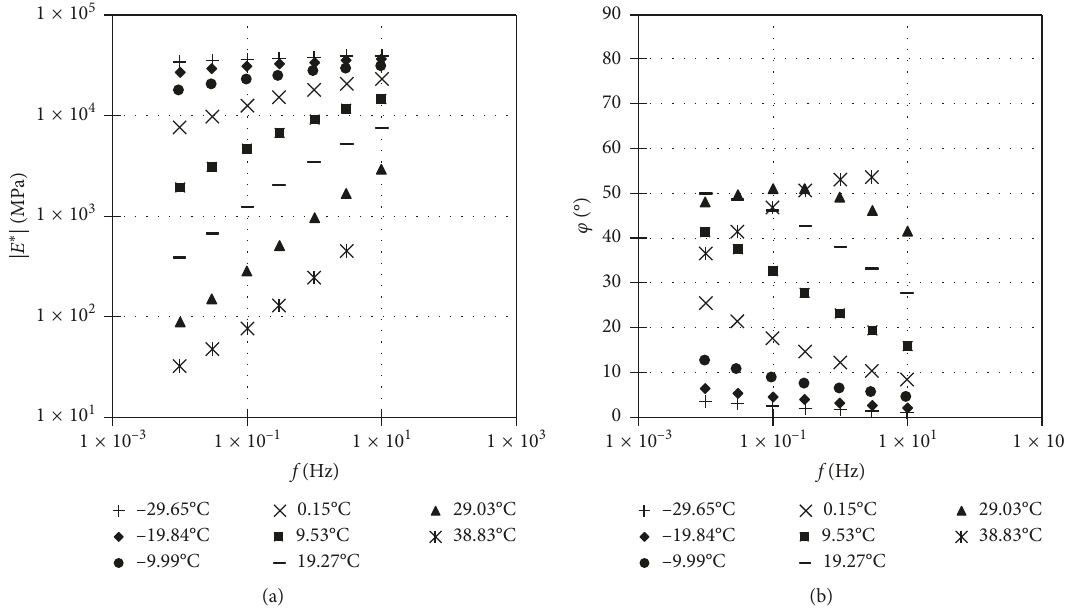
Figure 3: Experimental data of the bituminous mixture given to calibration panel: isotherms of norm (a) and phase angle (b) of complex modulus